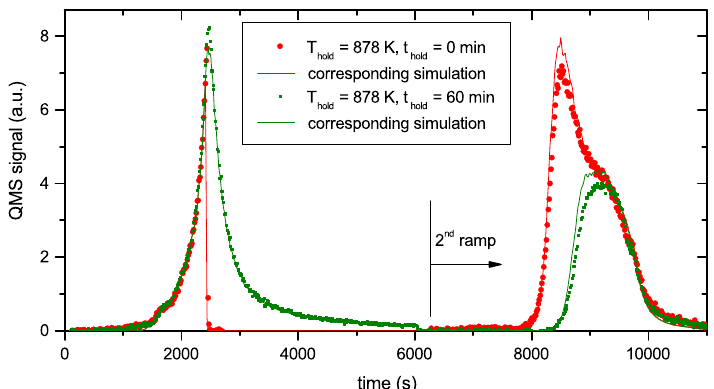
Figure 9. Comparison of experimental and model data for two Ramp-and-Hold experiments with T h = 878 K and t h = 0 and 60 min, respectively. The time scales of the first and second ramp are concatenated in this plot. The start of the second ramp is set to 6250 s and is indicated in the figure. The generic binding energy distribution extracted from the data is presented in Figure 10.